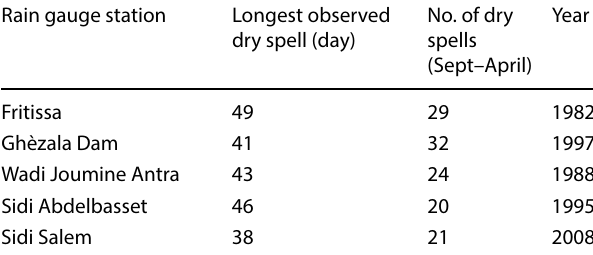
Table 4 Longest observed dry spell duration (day) at rain gauge stations (Ichkeul lake basin) Rain gauge